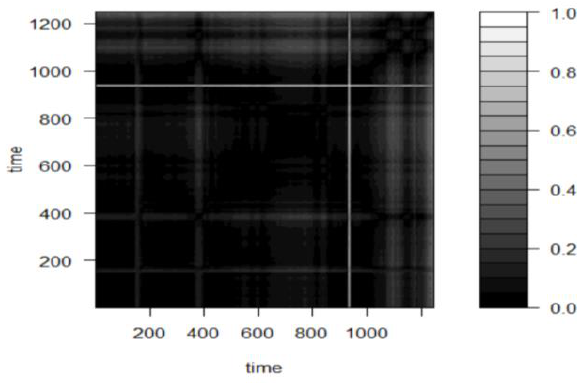
Figure 6: Recurrence Plot-Natural Gas; Source: Author Figure 7, 8 and 9 show the determination of embedding dimension, based on false nearest neighbourhood algorithm. The minimum embedding dimension has been defined as the value of m such that any further increase does not significantly increase the distance between any two neighbouring points in the trajectory. If we use the FNN metric to measure the usefulness of new dimensions, we should stop increasing m when the FNN has become very small, so that a further increase in m does not add much to the description of the dynamics of the system, while adding to the complexity of the other computations. As can be easily seen, for Crude Brent oil, Global food index and Natural gas series 𝑚 = 7 , 𝑚 = 5 , and 𝑚 = 6 , respectively.